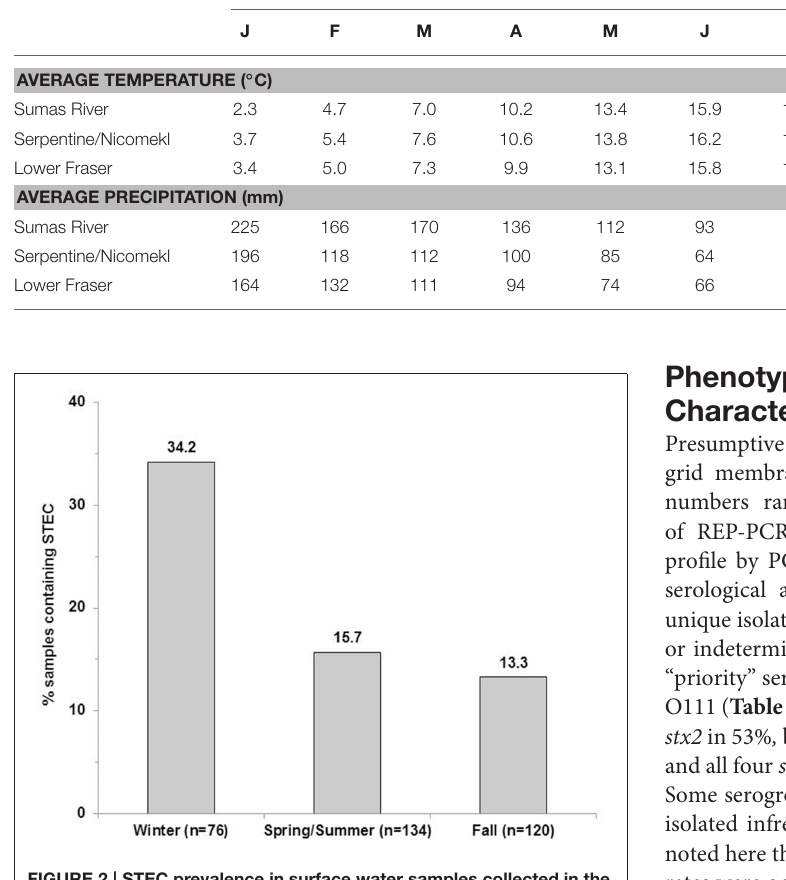
TABLE 2 | Average monthly temperatures and precipitation in four watersheds of the Lower Mainland of British Columbia. Watershed Month